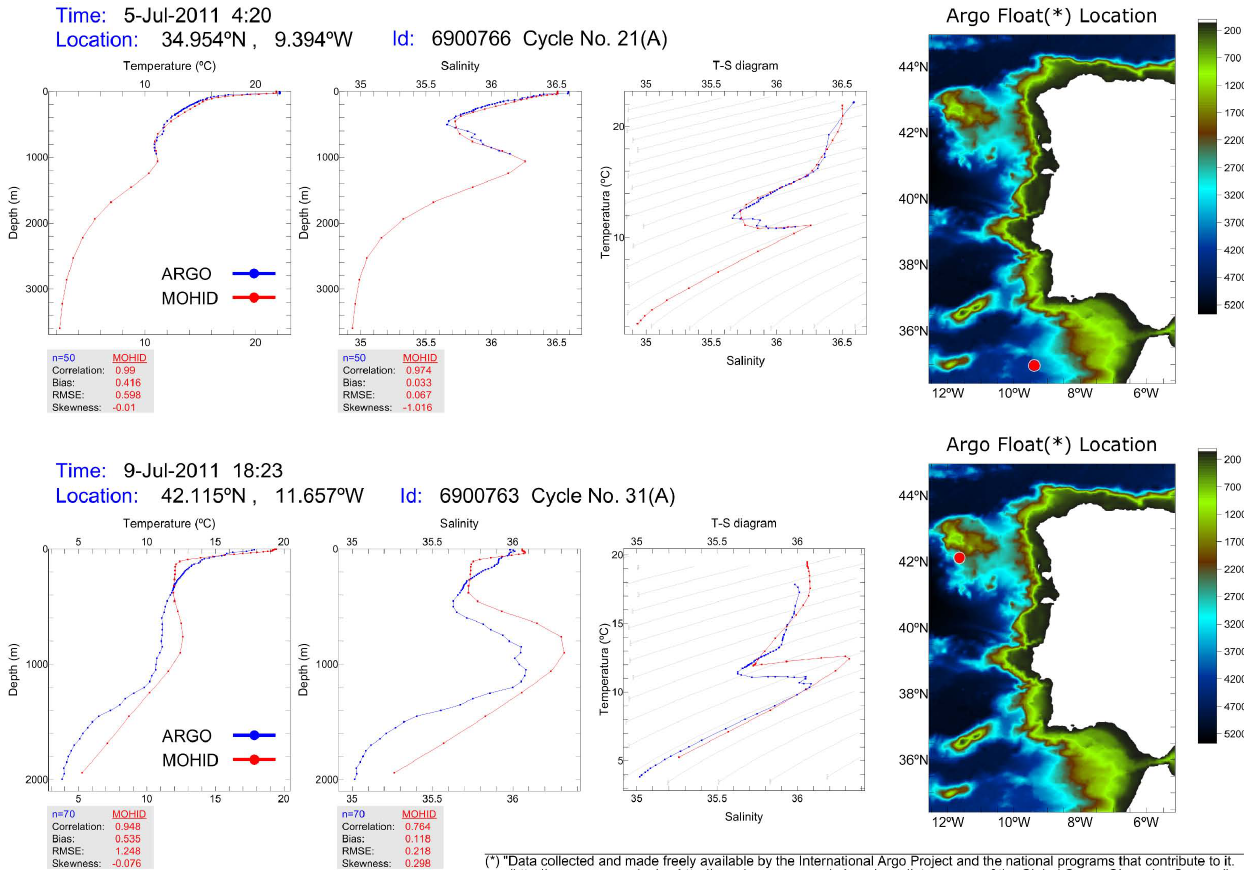
Fig. 11. Simulated temperature and salinity profiles for July 2011 compared with Argo data. The locations of the buoy are represented in the maps by a red circle. Statistical results are also present for each